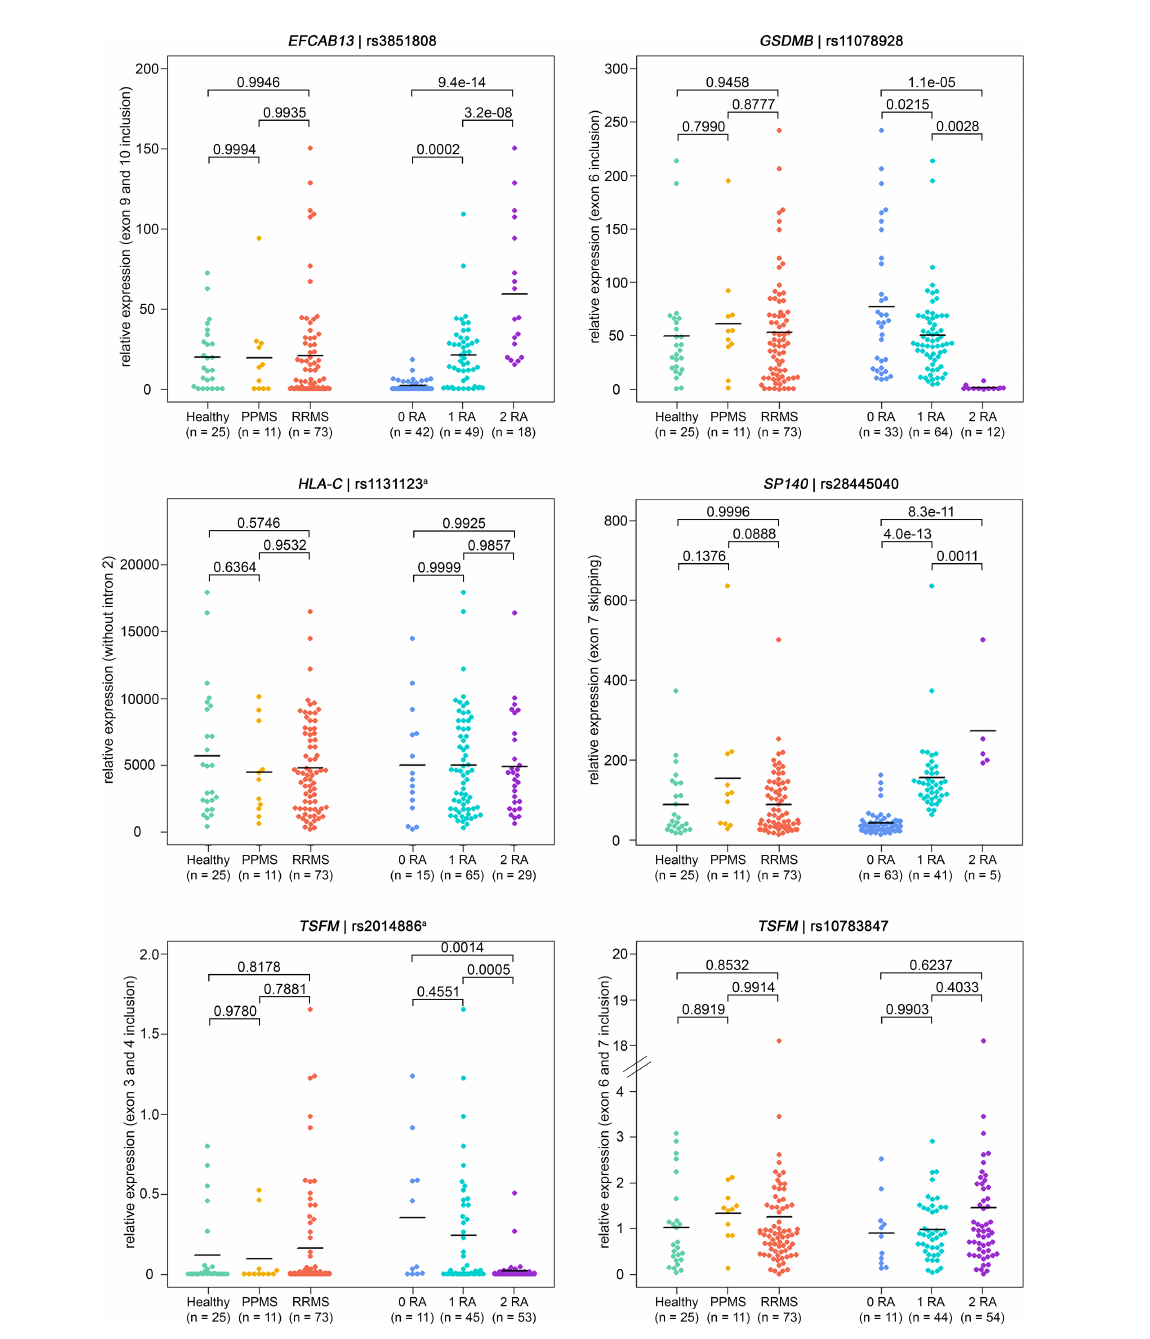
FIGURE 3 Veri fi cation of ASEs in MS patients vs . healthy controls and in relation to splice SNP genotypes. Relative expression as measured in B cells by qPCR (n = 109 samples). The same ASEs as in Figure 2 are visualized (but for HLA-C related to the isoform with intron 2 spliced out). Means per group are shown as horizontal black lines. Shown are the comparisons of mRNA isoform expression levels between the three study groups (on the left) and between the splice SNP genotypes (on the right). P-values from pairwise Tukey post-hoc analyses and the number of samples for each group are given. The numbering of exons and introns is as speci fi ed in Table 1. a For technical reasons, the designated splice SNP was tagged by a proximal SNP (Supplementary fi le). ASE, alternative splicing event; MS, multiple sclerosis; PPMS, primary progressive MS;